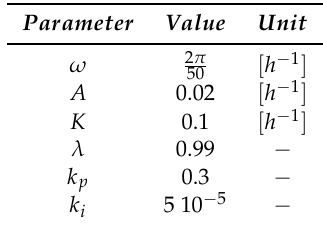
Table 3. PIRLS-ES controller